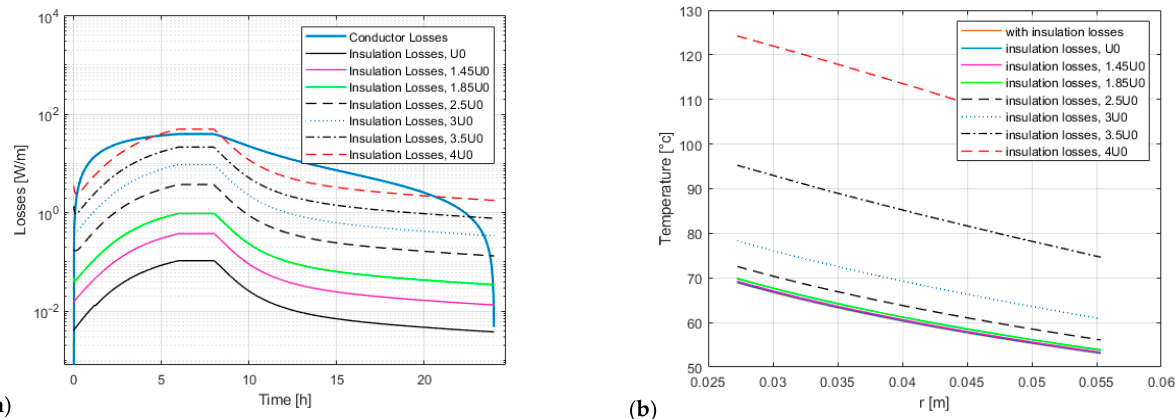
Figure 6. ( a ) insulation losses of a 500 kV DC-XLPE cable during a 24-h load cycle after [12] vs. applied voltage; ( b ) insulation temperature rise of the same cable at full load due to dielectric losses vs. applied voltage. Conductivity coefficients a = 0.085 K − 1 , b = 0.0645 mm/kV (after [164]).